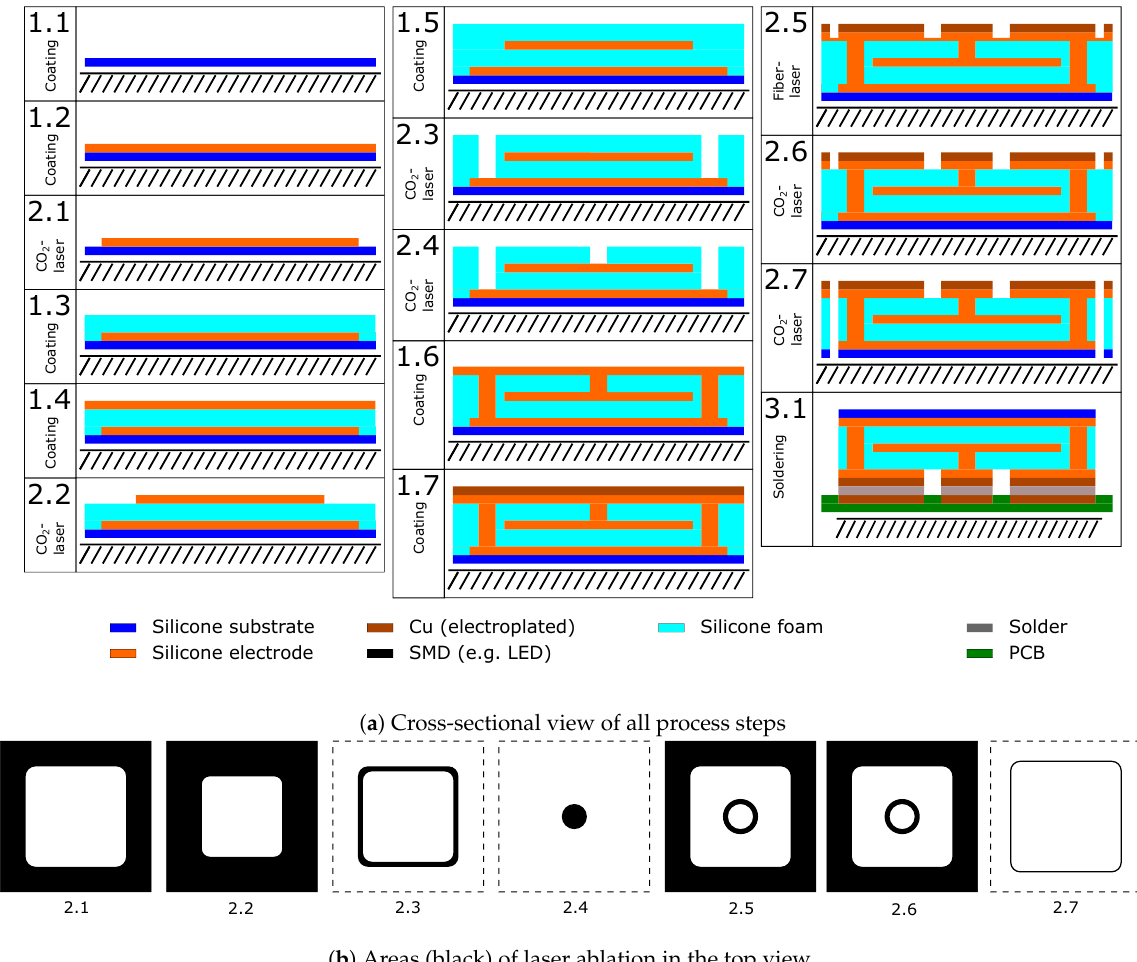
Figure 3. Schematic representation of the coating and laser structuring steps for manufacturing a dielectric elastomer pressure sensor (drawing not to